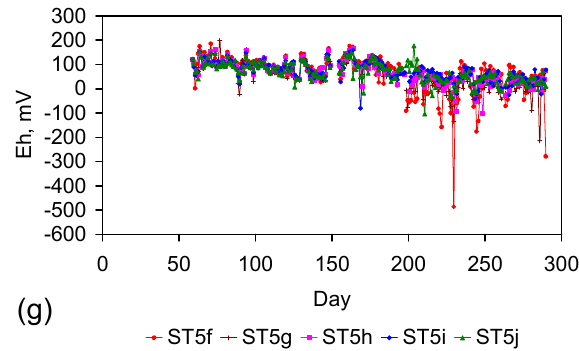
Figure C9. ( a ) pH vs. Eh; ( b ) EC vs. day, ST5a–ST5e; ( c) EC vs. day, ST5f–ST5j; ( d ) pH vs. day, ST5a–ST5e; ( e ) pH vs. day, ST5f–ST5j; ( f ) Eh vs. day, ST5a–ST5e; ( g ) Eh vs. day, ST5f–ST5j. ZVM TP = copper sheathed pellets (15 mm OD) placed in water at a concentration of ST5a = 64 g·L − 1 ; ST5b = 47.5 g·L − 1 ; ST5c = 48 g·L − 1 ; ST5d = 62.5 g·L − 1 ; ST5e = 94 g·L − 1 ; ST5f = 47.5 g·L − 1 ; ST5g = 38 g·L − 1 ; ST5h = 46 g·L − 1 ; ST5i = 39.5 g·L − 1 ; ST5j = 72.5 g·L − 1 . Reactor Size: 0.3 L; Feed Water volume: 0.2 L.